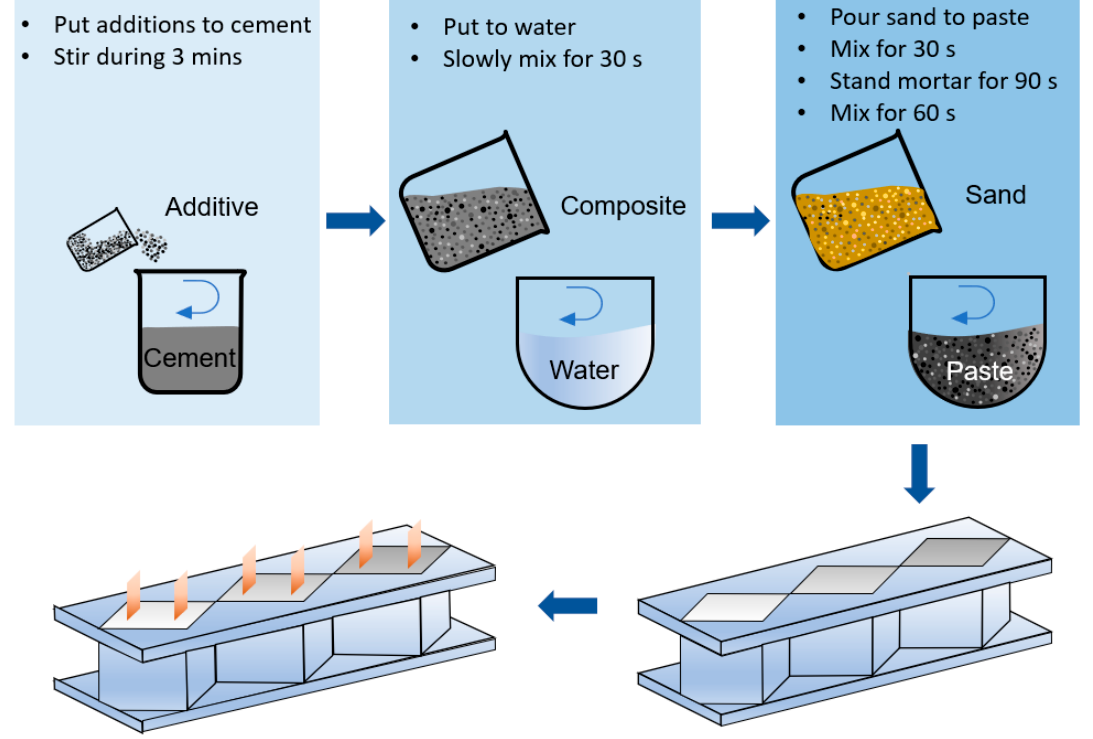
Figure 2. Mortar preparation process.